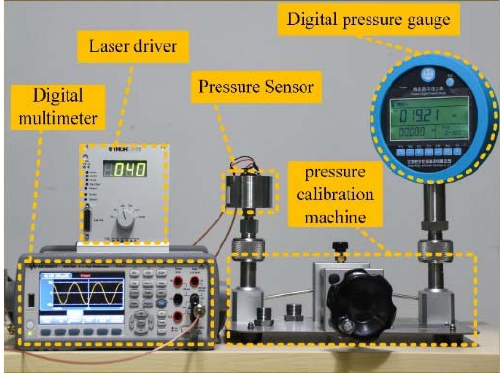
Figure 8. The pressure sensor performance test platform.